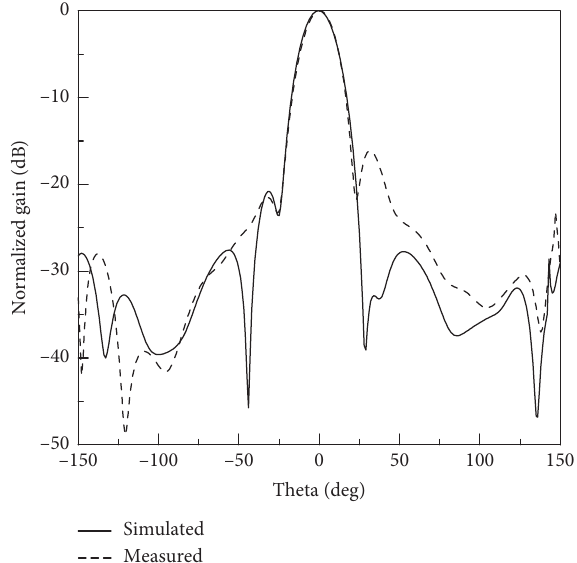
Figure 12: Return loss characteristics of the proposed nose-cone conformal slot array. Figure 13: H-plane radiation characteristics of the proposed nose- cone conformal slot